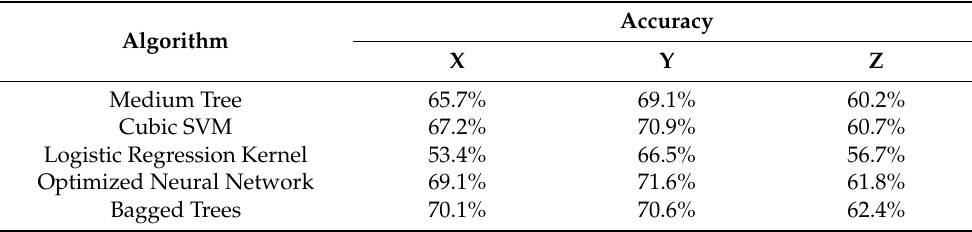
Table 2. Algorithms precision